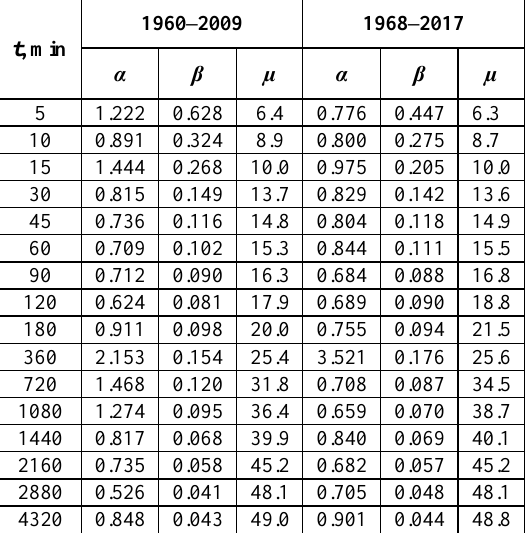
Table 2. Calculated parameters of the GED distribution.